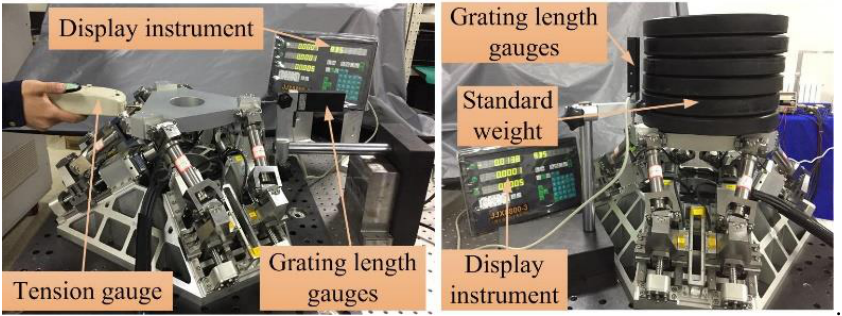
Figure 15. Static stiffness testing of the parallel platform.